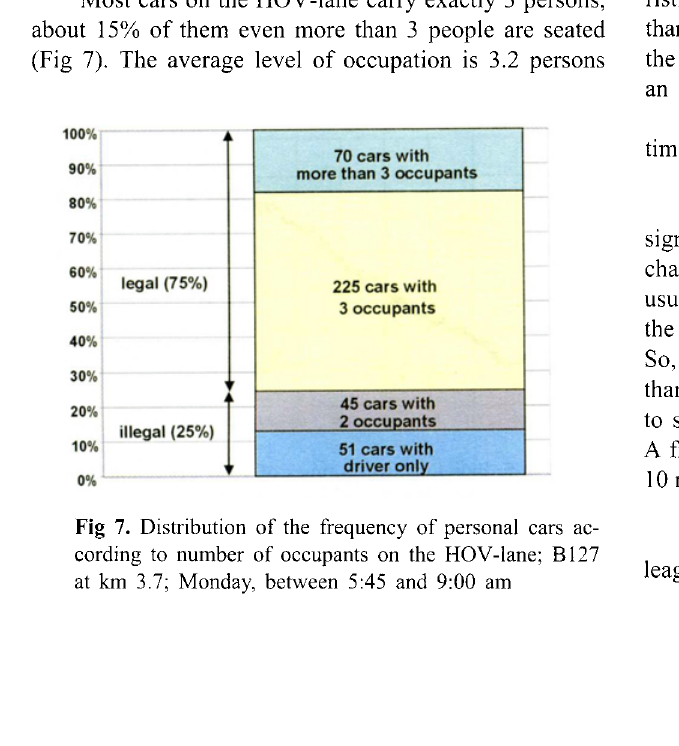
Fig 7. Distribution of the frequency of personal cars ac cording to number of occupants on the HOY-lane; Bl27 at km 3.7; Monday, between 5:45 and 9:00